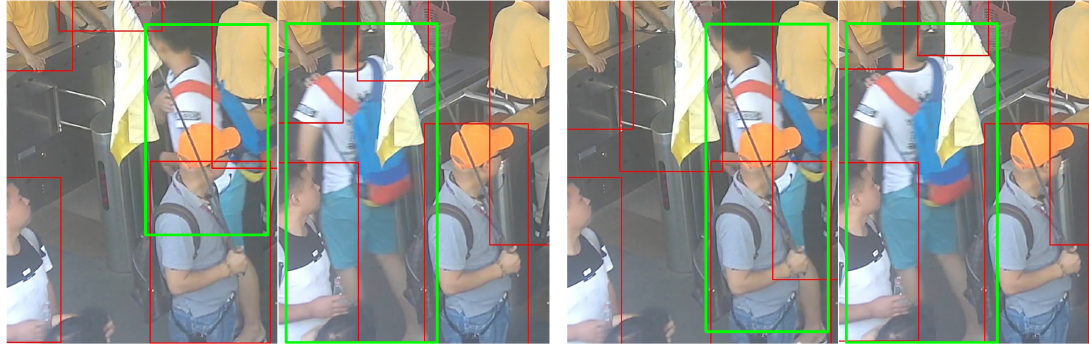
Figure 4. The deformation of the bounding box of a single target without ( left ) and with ( right ) shape adjusting.